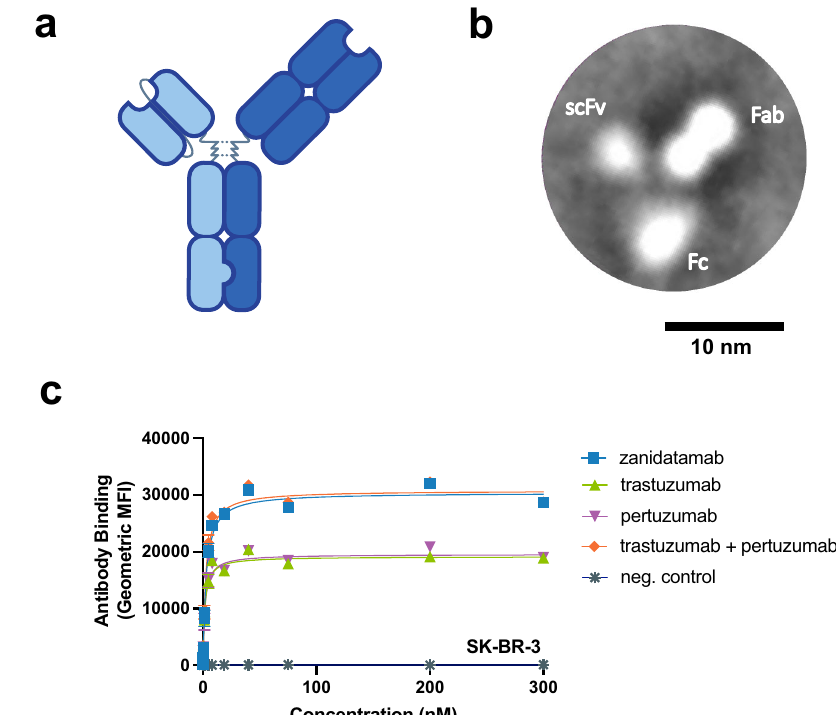
Fig. 1 | Zanidatamabis a biparatopic anti-HER2Ab thatbinds HER2-expressing tumor cells with greater Ab saturation than trastuzumab or pertuzumab. a Zanidatamab is a humanized, biparatopic, immunoglobulin 1 (IgG1)-like Ab with an scFv (light blue) that binds the juxtamembrane ECD4 of HER2 and a Fab (dark blue) that binds the ECD2 dimerization domain of HER2, the same domains tar- geted by trastuzumab and pertuzumab, respectively. b Representative class- averaged TEM image, derived from 216 images, showing the 3-lobed structure of